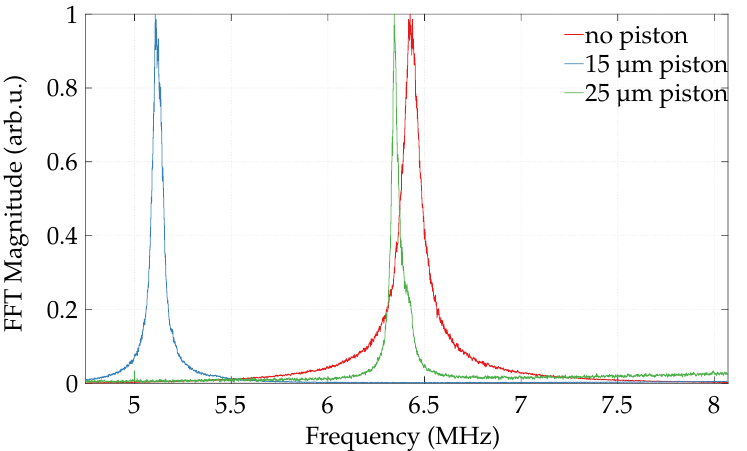
Figure 6. Vibrometer measurements for detecting resonance frequencies of weakly biased (2V DC ) CMUTs with no piston, and with 15µm and 25µm wide pistons. Graphs show the normalized average of 90 cells of each